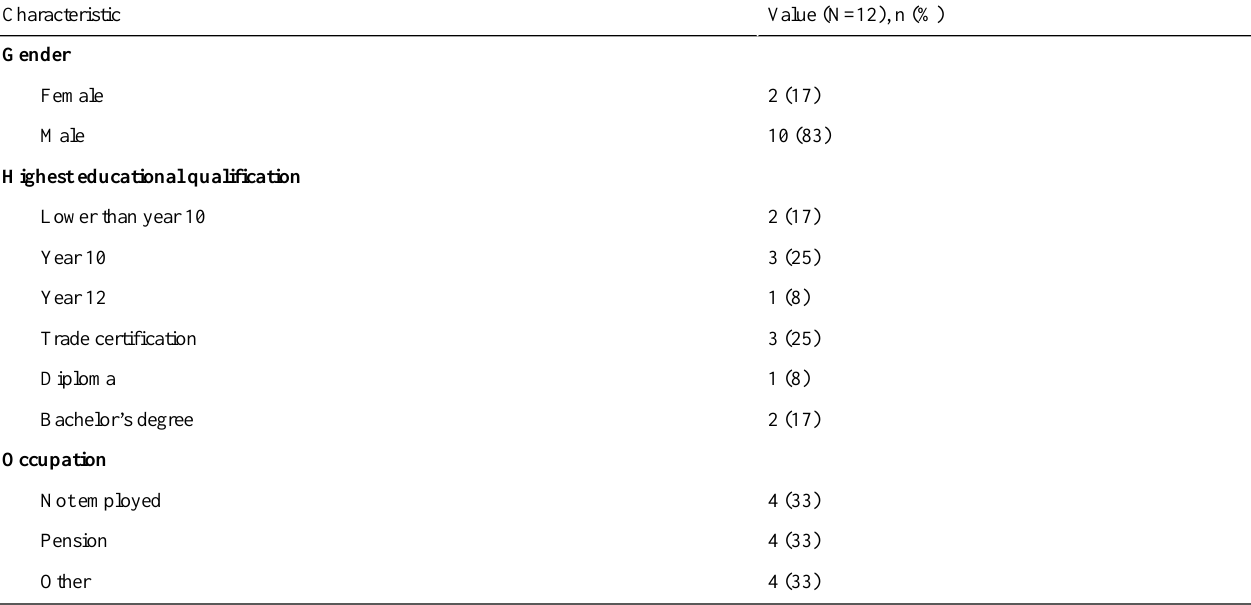
Table 1. Demographic characteristics of patients who were